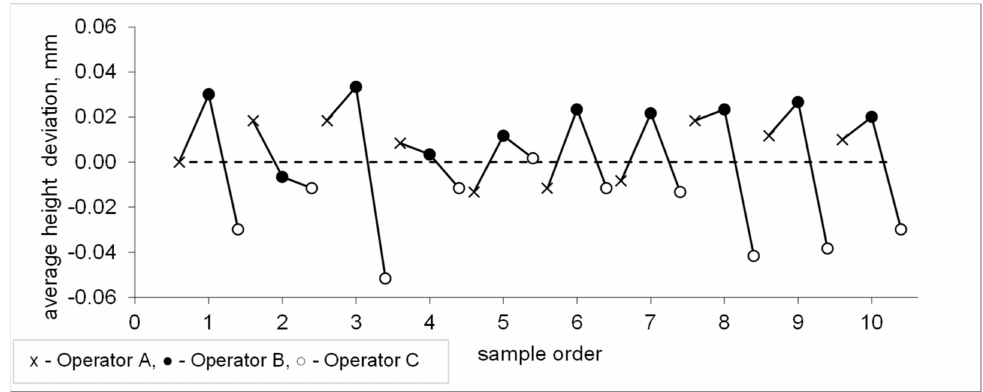
Figure 9. Diagram of deviations of averages achieved by individual operators for individual samples from the total average of all measurements of a given